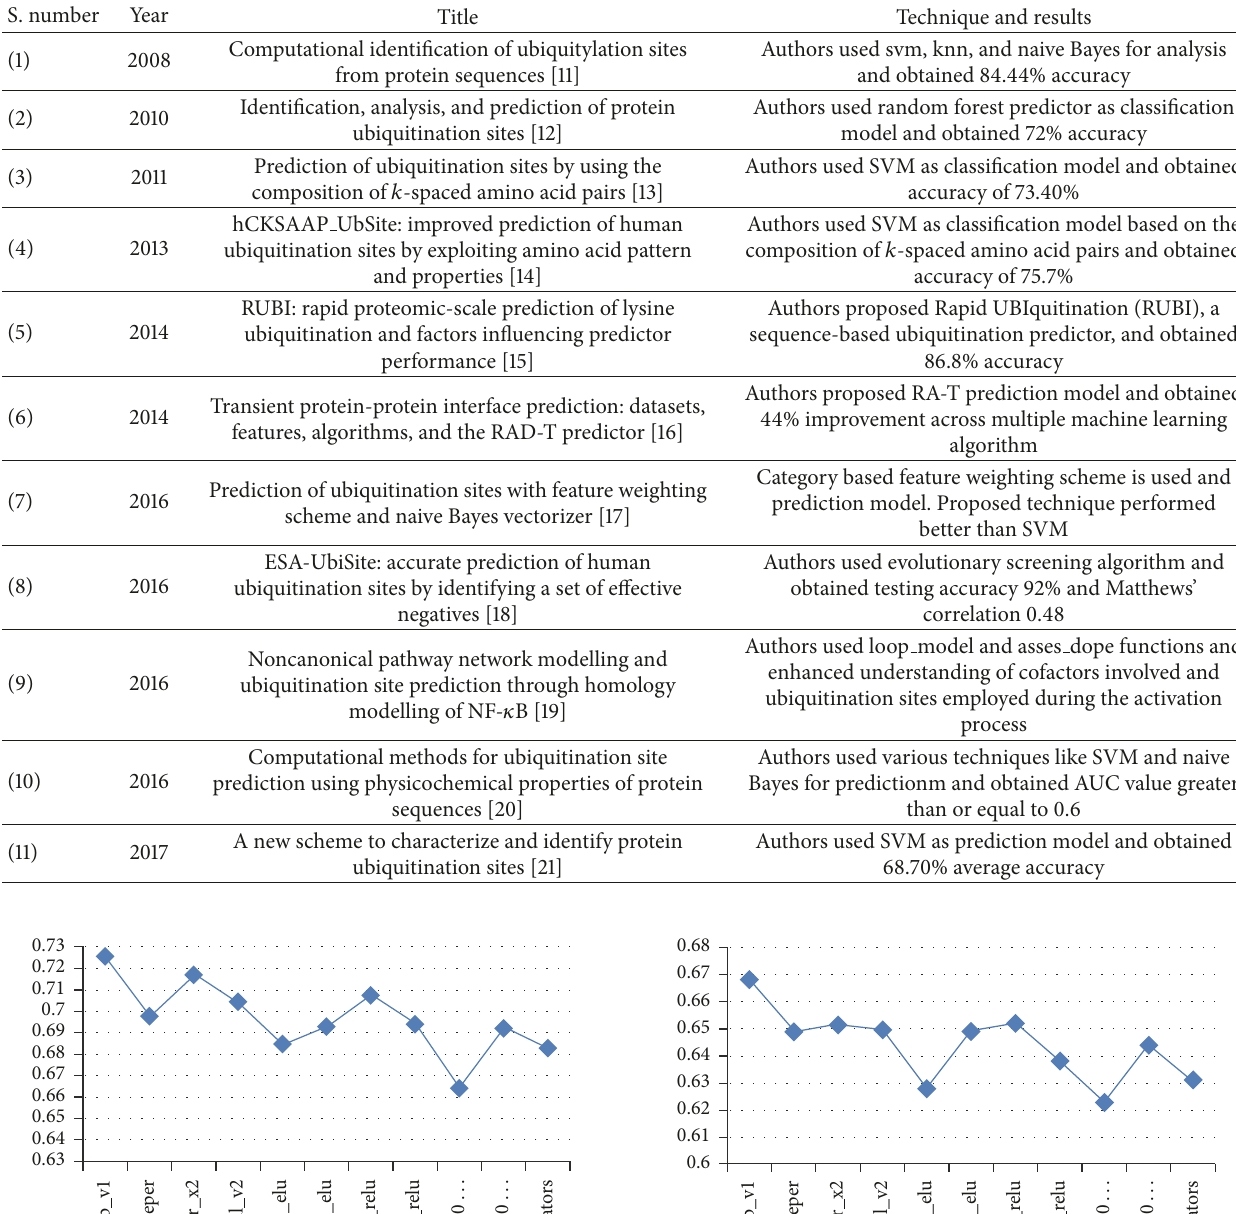
Table 1: Related work in chronological order.